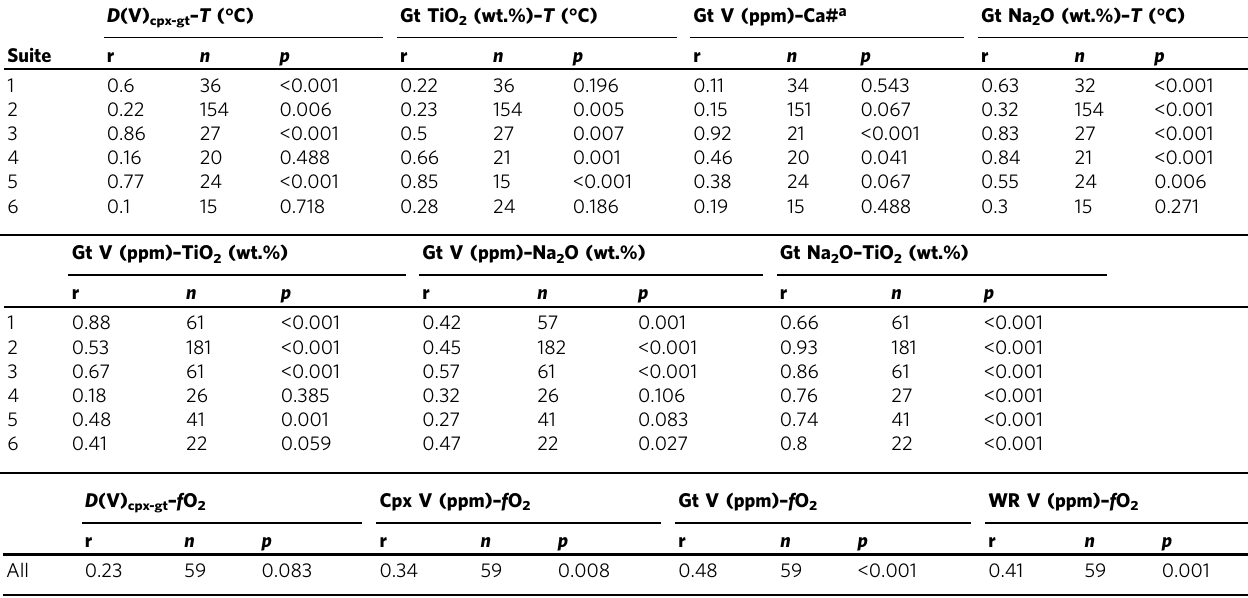
Table 2 Pearson correlation coef fi cents and statistical signi fi cance test for various variables discussed in the text (references in Supplementary Data